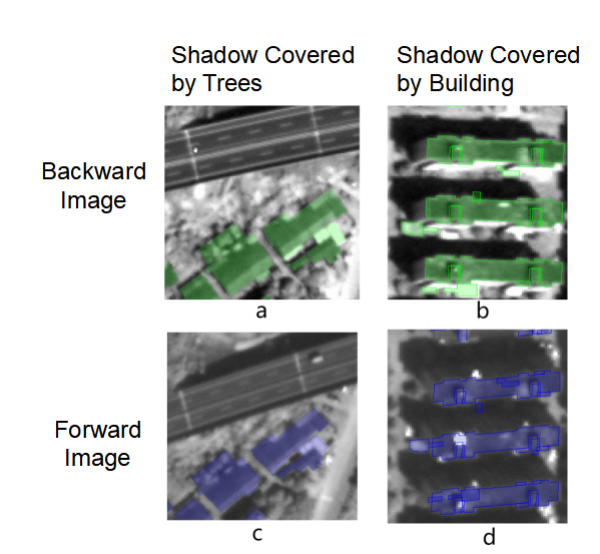
Figure 17. The illustration of shadow occlusions. ( a , c ) building shadows occluded by trees; ( b , d ) build- ing shadows occluded by buildings.